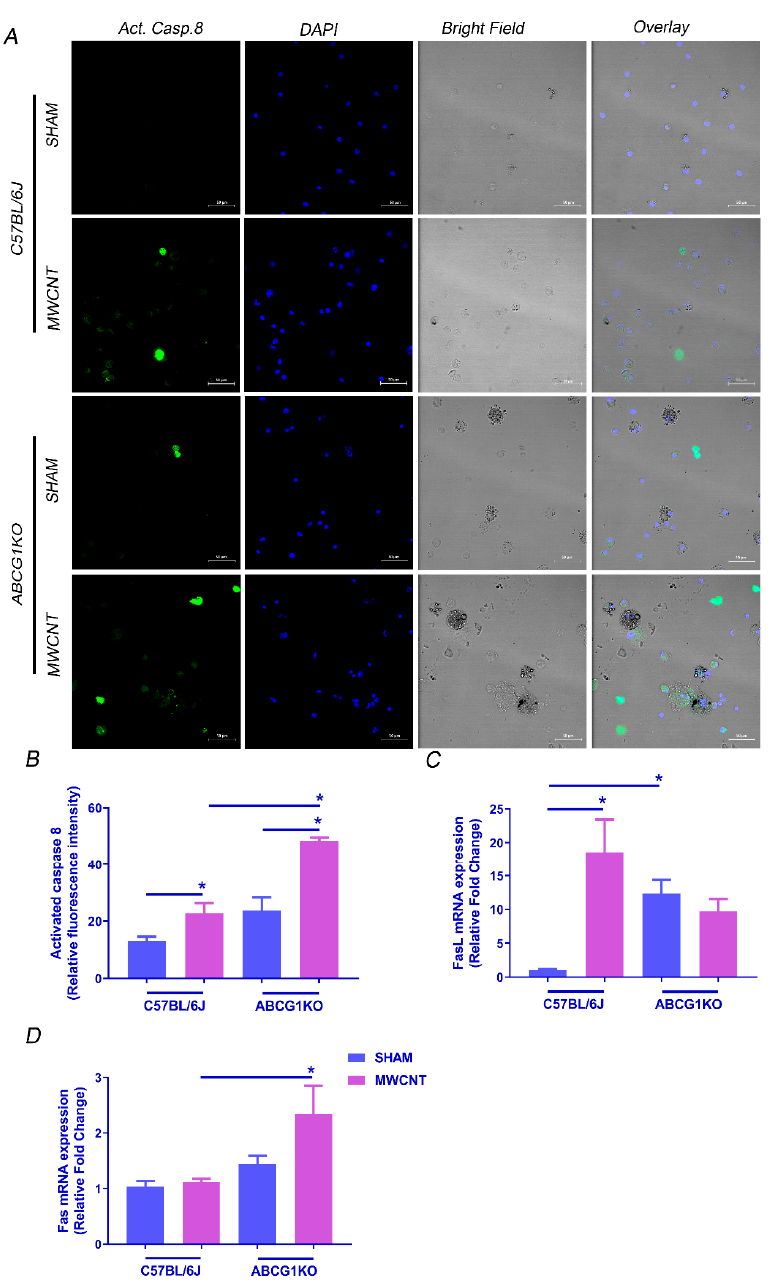
Figure 3. Myeloid ABCG1 deficiency increases caspase 8-mediated extrinsic apoptotic pathway by MWCNT . ( A ) Measurement of activated caspase 8 in BAL cells of wild type and ABCG1 KO mice. Cytospins of BAL cells from wild type and ABCG1 KO mice either sham or MWCNT instilled were